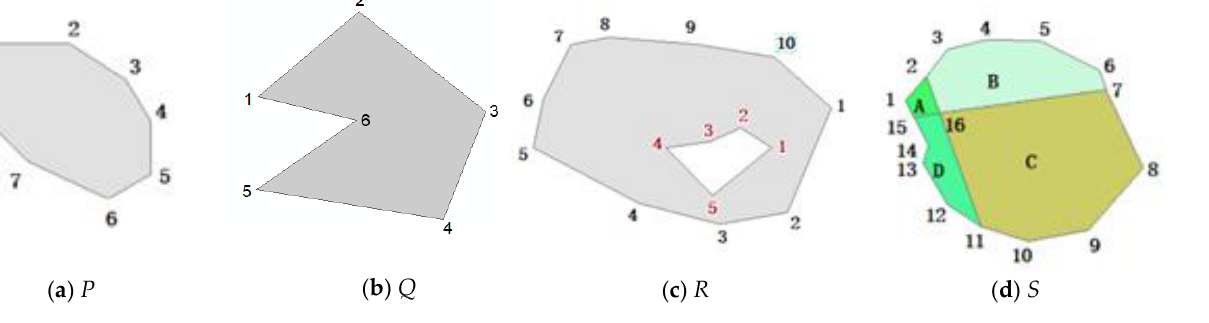
Figure 1. Four different types of polygons.